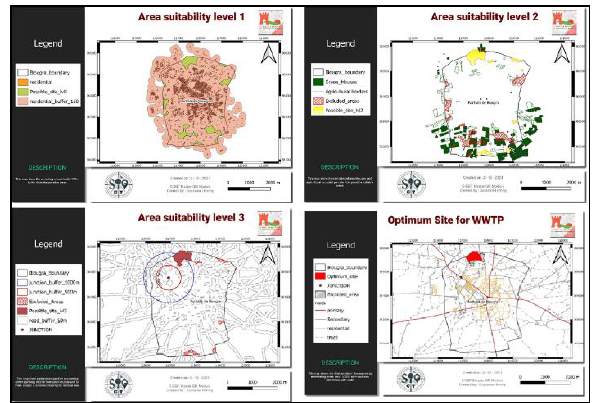
Figure 6 . Area suitability